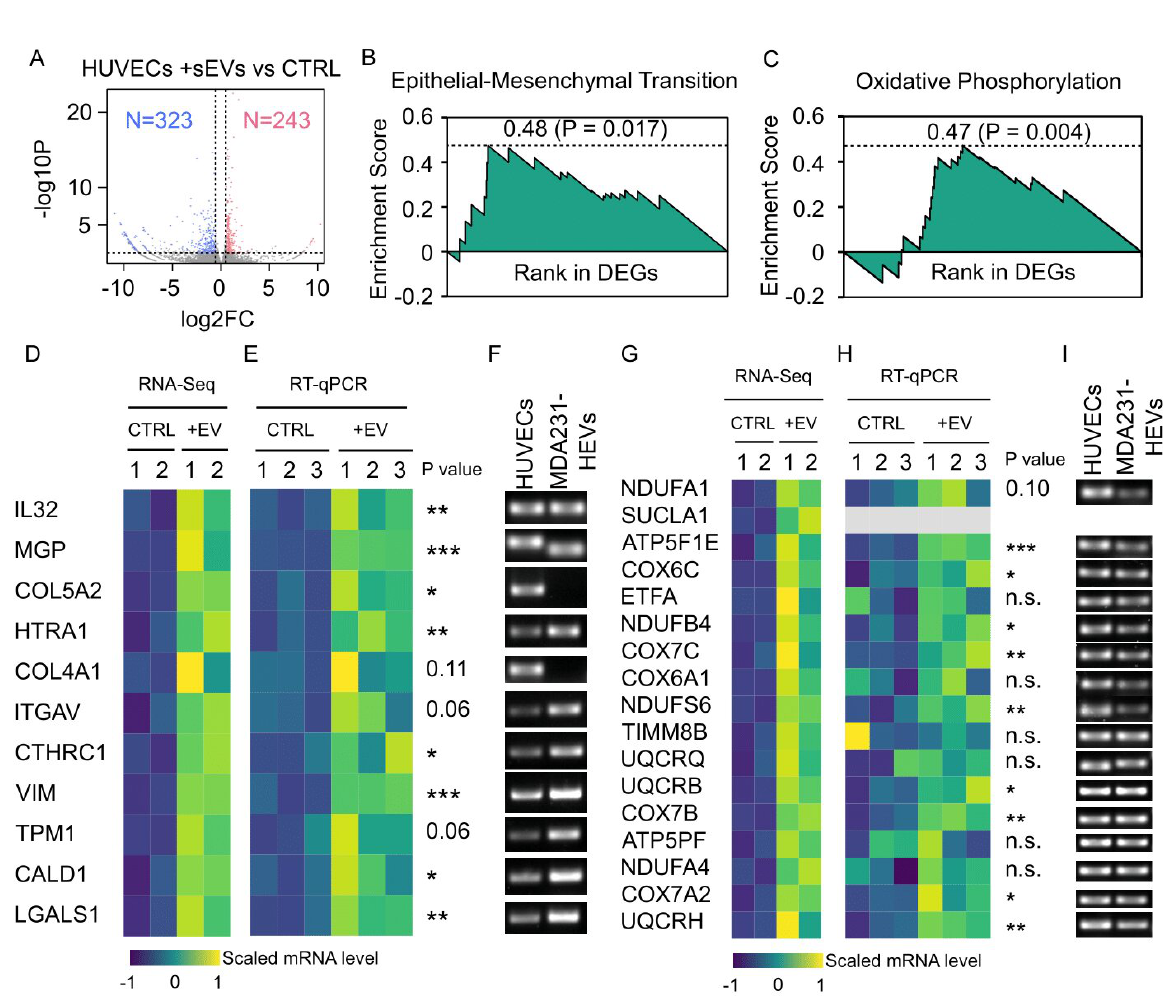
14 of 21 (ES = 0.471, P = 0.004) (Figure 6B,C). These two gene sets included a total of 28 upregulated genes (Figure 6D,G), most of which were confirmed to be significant by RT-qPCR (Figure